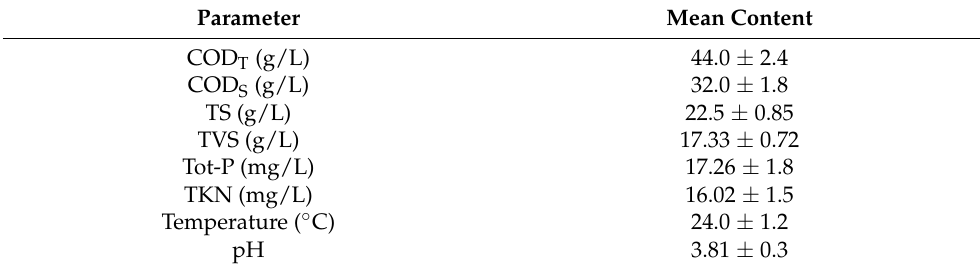
Table 1. Average composition of the FVW 1